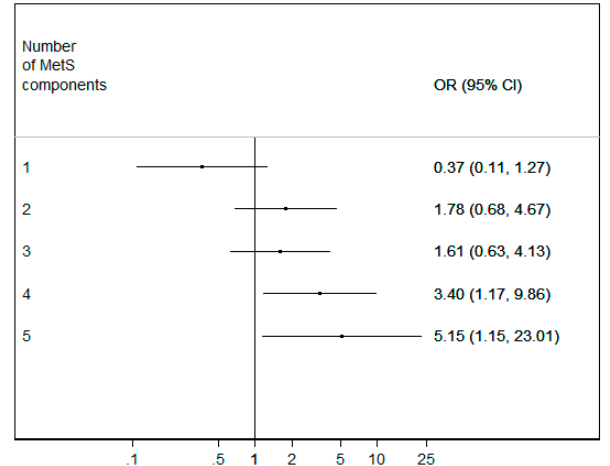
Figure 1. Tumor risk depending on the presence of different numbers of individual MetS components. WD GEP-NETs (well-differentiated gastro-enteric-pancreatic neuroendocrine tumors), OR (odds ratio), CI (confidence interval), and MetS (Metabolic Syndrome).